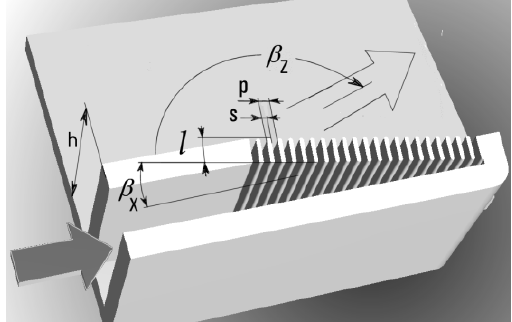
Fig. 16. Geometry of the computation domain with the inlet channel of rectangular cross section. and absence of the reflected flow. This different character of the domain was introduced to make possible a better detailed study of the flow past the cascade elements.